Question: Write the caption for this figure.
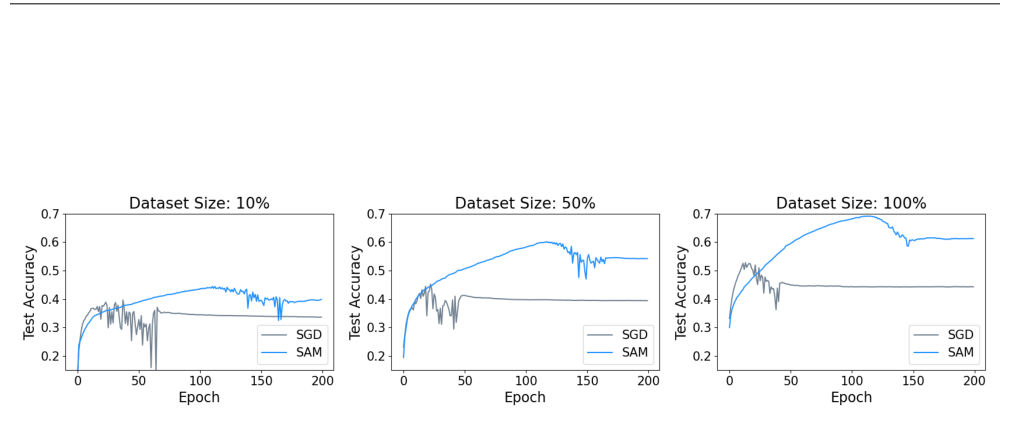
Answer: Behavior with number of training examples for ResNet18/CIFAR10 with 30% label noise We compare SGD and SAM trained on different number of training examples (10, 50, 100% of the training data). We see that the difference between SAM (ρ = 0.01) and SGD increases as the dataset size increases.